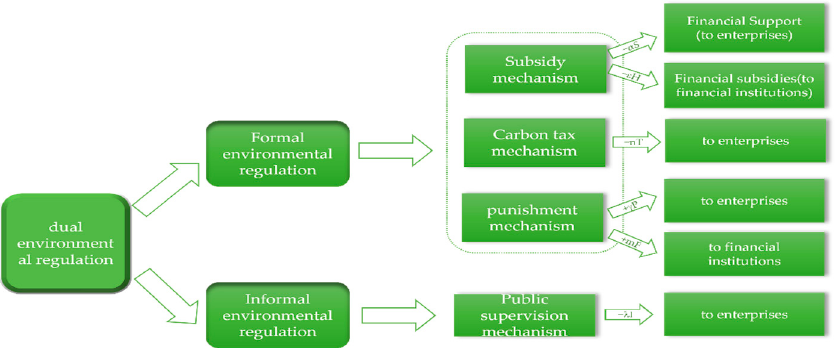
Figure 3. Specific settings for dual environmental regulations.